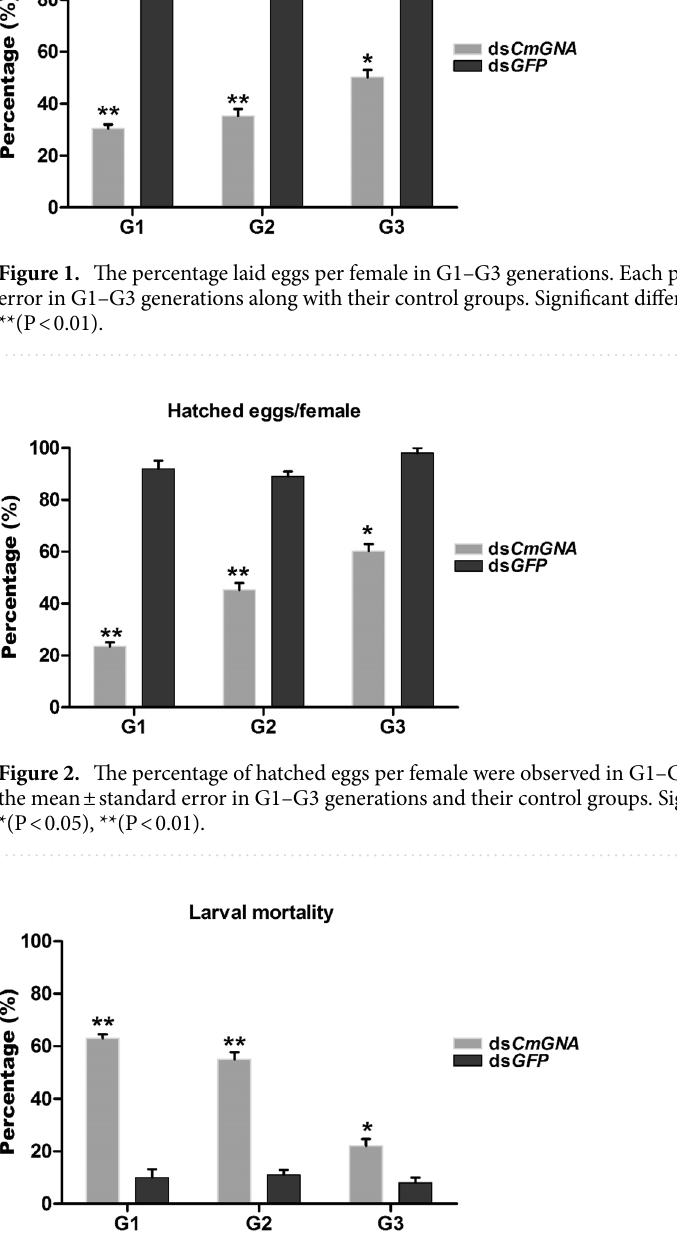
Figure 3. The percentage of larval mortalities were observed in G1–G3 generations. Each point indicates the mean ± standard error in G1–G3, and their control groups. Significant differences indicated by *(P < 0.05), **(P <